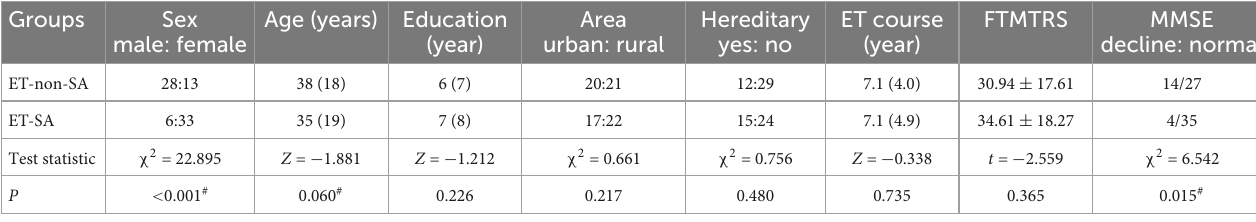
TABLE 4 Single-variable analysis of risk factors for essential tremor patients with social anxiety (ET-SA) (Tremor position). Groups Face Sound Tongue Head Upper limb Trunk Lower limbs